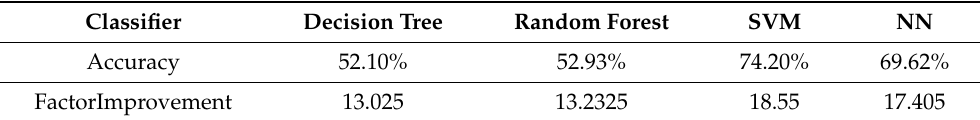
Table 2. Performance of different algorithms at classifying cell m-type (25 classes, 4% equivalent random guessing accuracy).